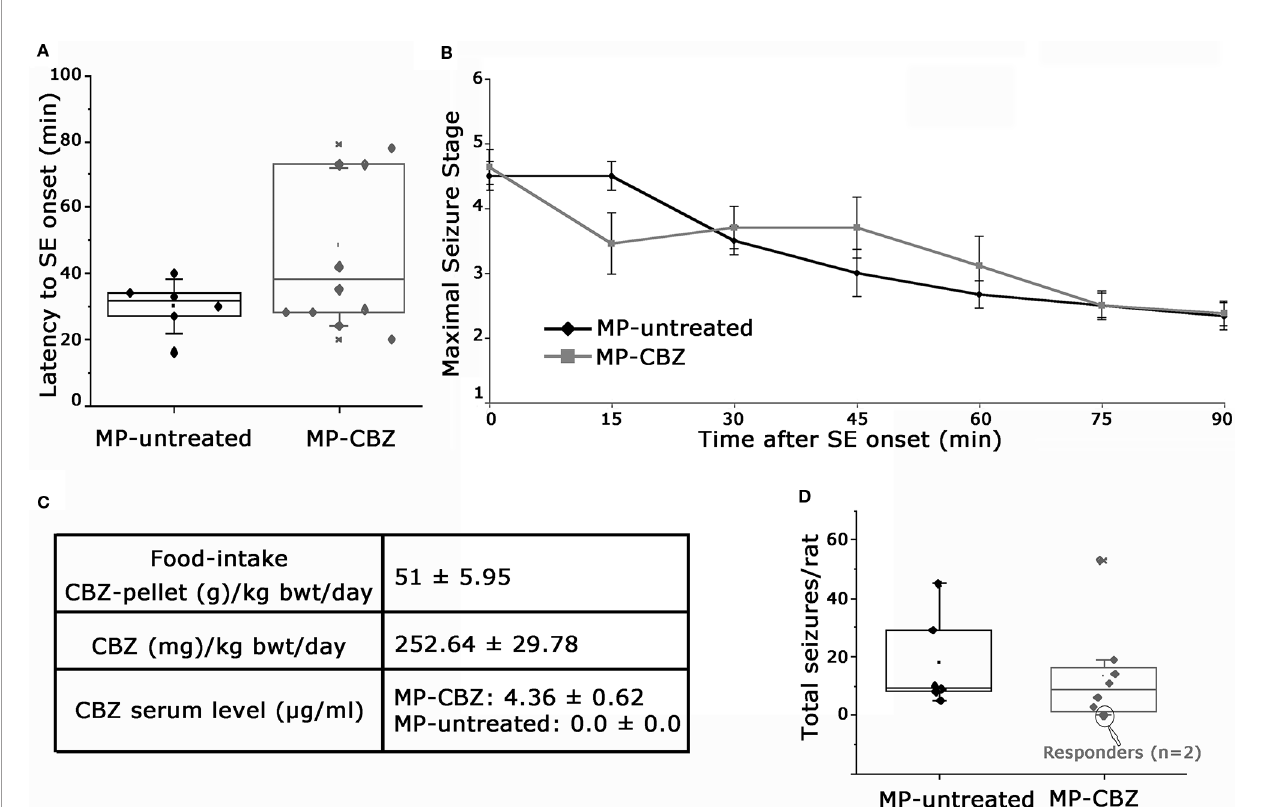
FIGURE 1 | Behavioral assessment of status epilepticus and SRS and data of CBZ-in-food trial. (A) Box plot representation of latency (min) to onset of pilocarpine- induced SE in MP-untreated and MP-CBZ treated rats. No signi fi cant difference was observed between MP-CBZ and MP-untreated rats as assessed by means of Mann-Whitney U-test (respectively 30 ± 8.25 min vs 46 ± 23.77 min, p = 0.242). (B) Behavioral assessment of convulsive-motor seizure (stage 3-5) throughout status epilepticus, rated every 15 min over a 90 min observation period. No differences were observed between MP-untreated and MP-CBZ rat group at each time point considered as assessed by student t-test (SE onset, 0 min: p = 0.71; 15 min: p = 0.125; 30 min: p = 0.45; 45 min: p = 0.276; 60 min: p = 0.435; 75 min: p = 1; 90 min: p = 0.884; n = 6 rats in MP-untreated group; n = 10 rats in MP-CBZ group). Data are expressed as mean ± SD. (C) CBZ administration started after the fi rst spontaneous seizure and the drug was administered in food every 24 h (at 10 a.m.) for 2 months. The food intake corresponded to a normal caloric diet. Average CBZ dose per day was 252.64 ± 29.78 mg/kg/day (mean ± SD) and serum CBZ levels were within the range suggested for humans (4 – 12 m g/ml). (D) Box plot showing the total number of stage 4-7 CMS/per rat during the trial. No difference was observed between the two groups as assessed by means of Mann- Whitney U-test (mean SRS number ± SEM: 17.15 ± 6.48 and 13.23 ± 6.16, respectively for MP-untreated and MP-CBZ rat group, p = 0.560). Encircled dots in panel D represent 2 out of 8 MP-CBZ rats (MP-CBZ/responders) in which CBZ treatment totally affected convulsive stage 4-7 seizures. In A and D, the box ranges indicate the 25th and 75th percentile and whiskers represent SD